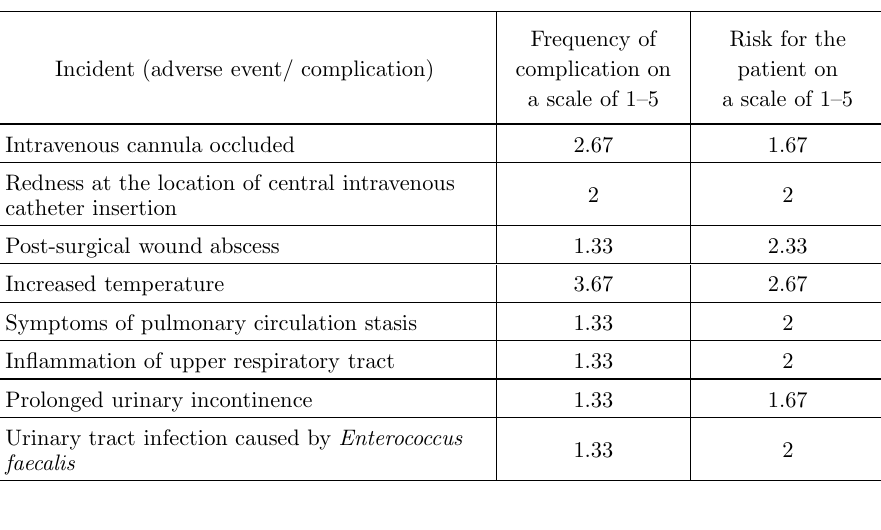
Table 6. Expert assessment for complications occurring during H05 settlement group hospitalisations